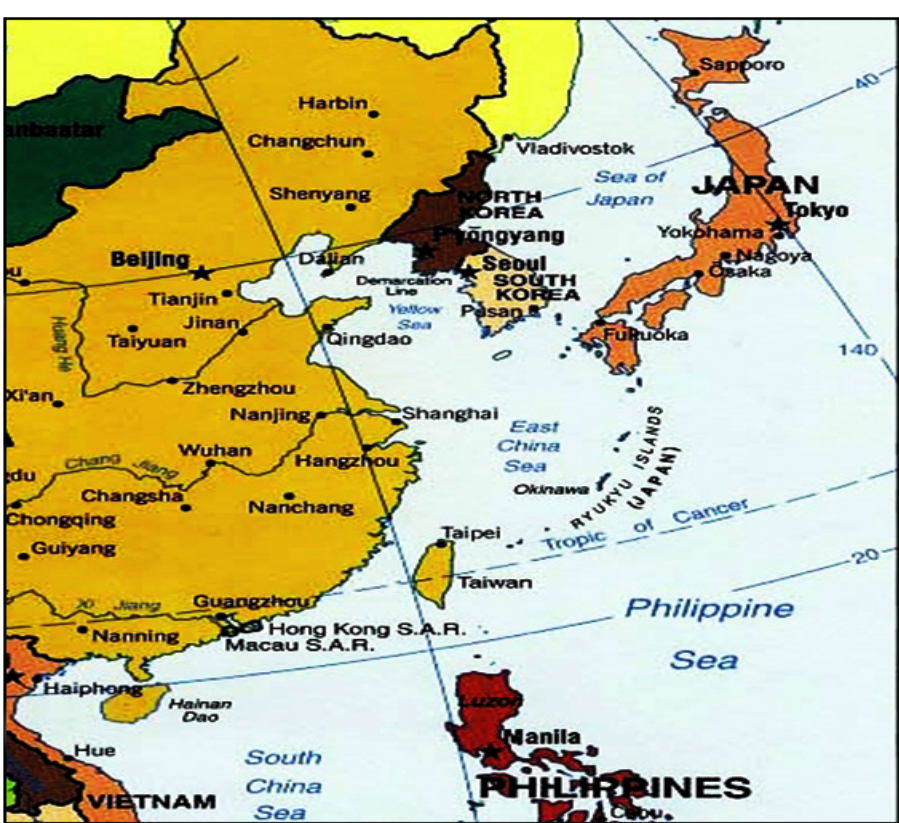
Figure 1. Geography of East